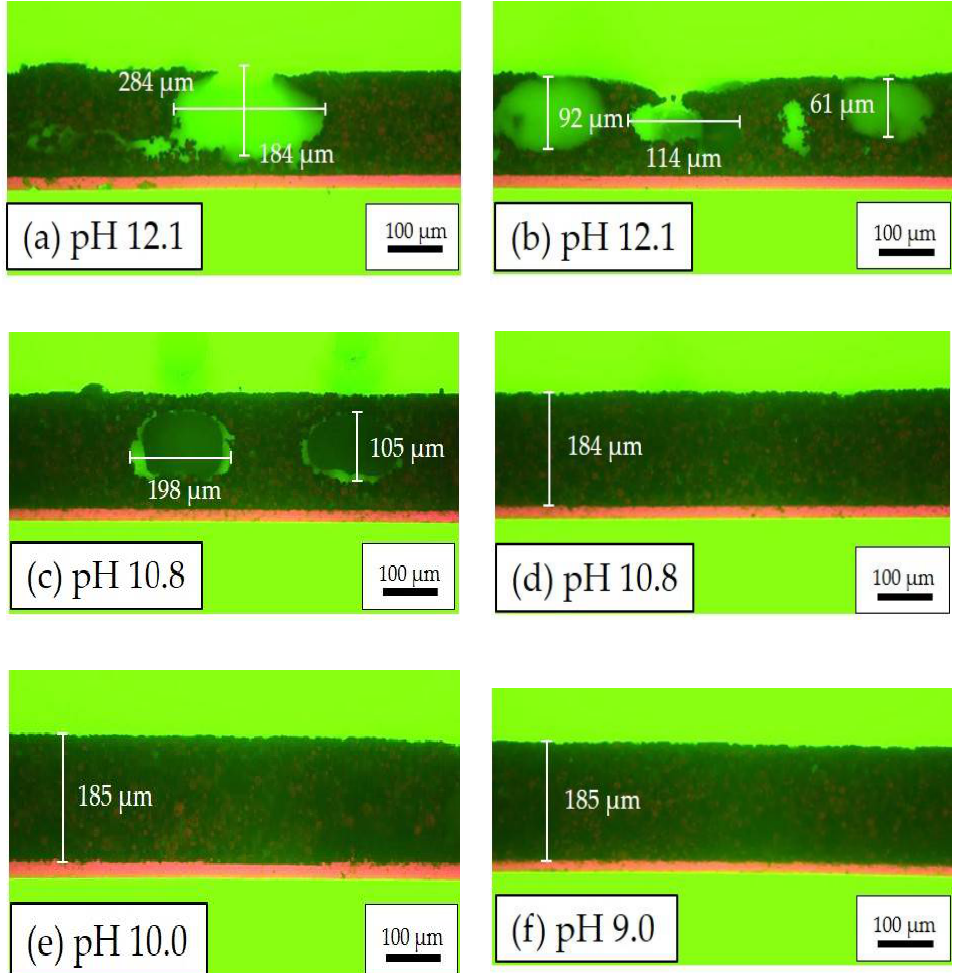
Figure 3. Microscope images of electrodes in cross-sectional view with different slurry pH values: ( a ) and ( b ) pH = 12.1; ( c ) and ( d ) pH = 10.8; ( e ) pH = 10.0; and ( f ) pH = 9.0.